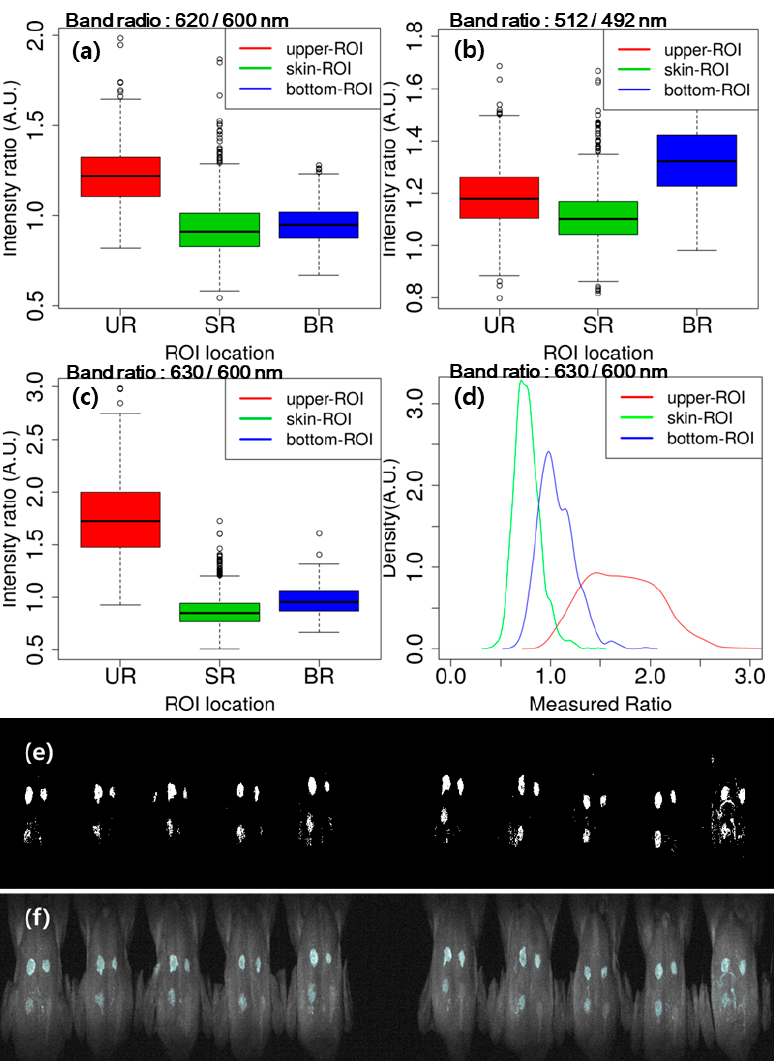
Figure 7. Band ratios for discrimination of upper-ROI (UR), skin-ROI (SR), and bottom-ROI (BR) with the fluorescence intensity of 620 and 600 nm ( a ), 512 and 492 nm ( b ), and 630 and 600 nm ( c ). Density plot ( d ) of the kernel density of band ratio 630/600 ( c ). Black and white image of the band ratio 630/600 nm ( e ) and its projection onto the sample images ( f ).